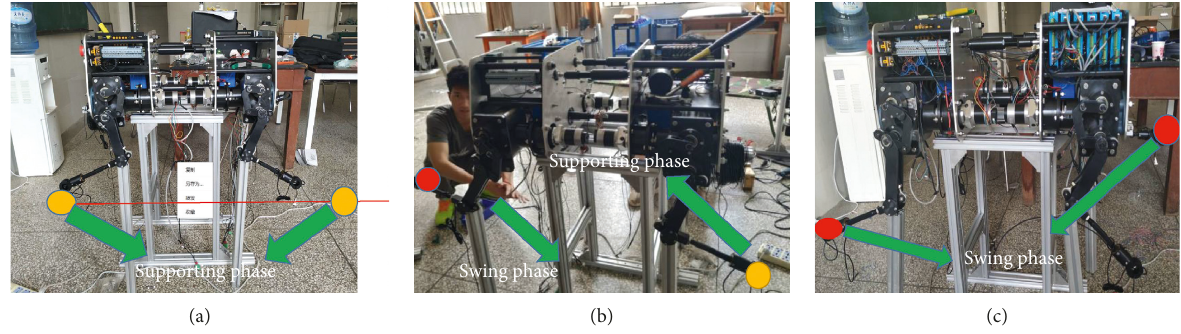
Figure 23: Gait switching process. (a) Initial position. (b) T � 2s walk gait. (c) T � 8 s tort gait.